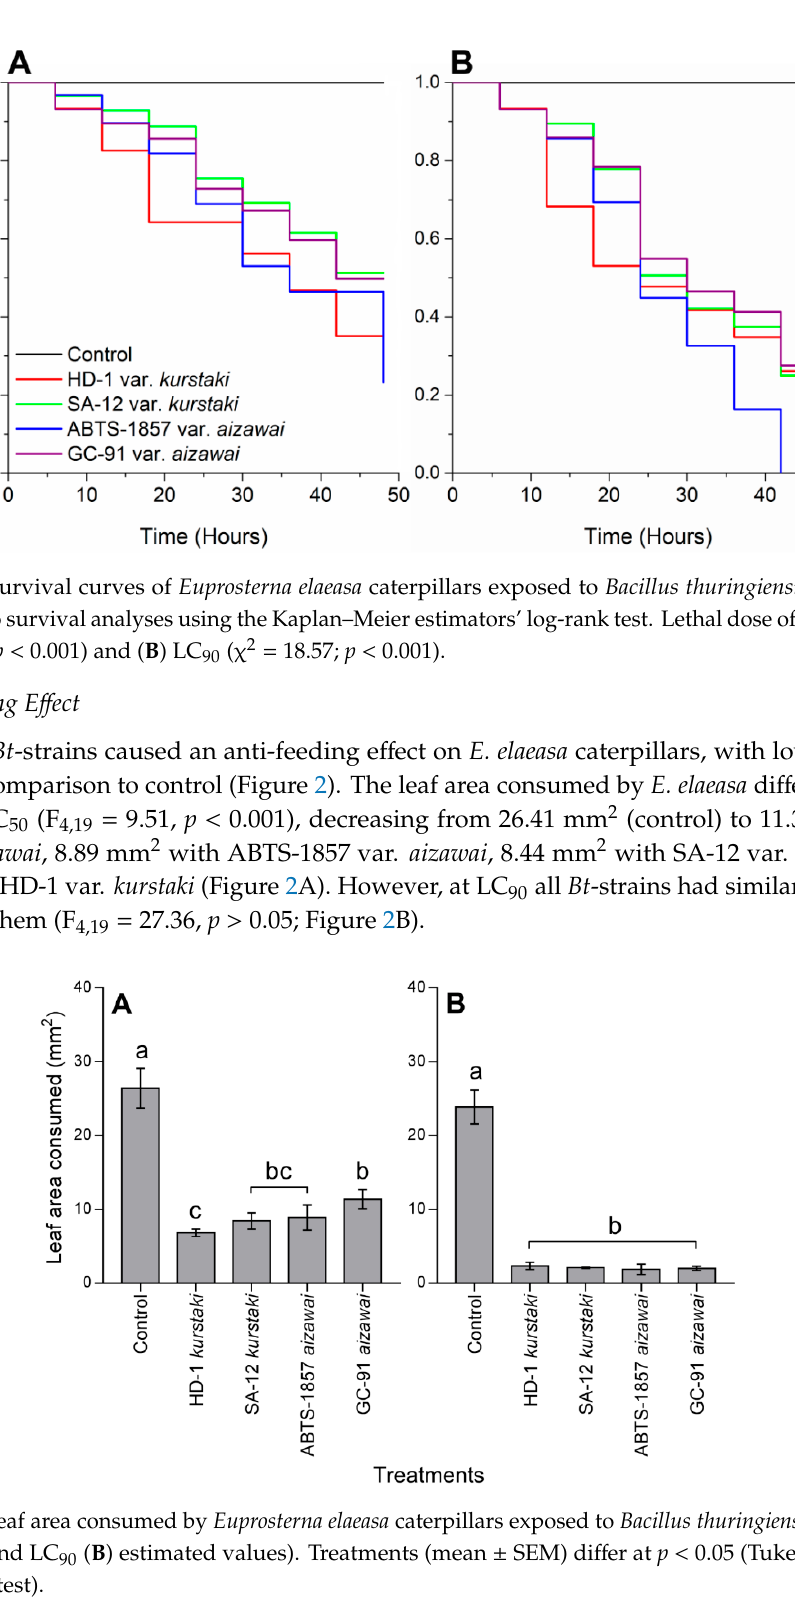
Figure 2. Leaf area consumed by Euprosterna elaeasa caterpillars exposed to Bacillus thuringiensis strains (LC 50 ( A ) and LC 90 ( B ) estimated values). Treatments (mean ± SEM) differ at p < 0.05 (Tukey’s mean separation test).